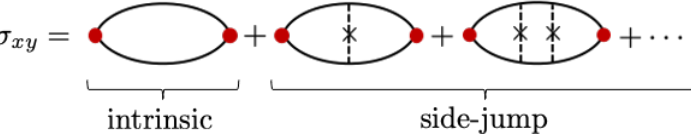
Figure 11: Diagrams contributing to the Hall conductivity in the intrinsic metallic region. The grouping into the intrinsic and side-jump parts corresponds to the usual labels given for these processes.